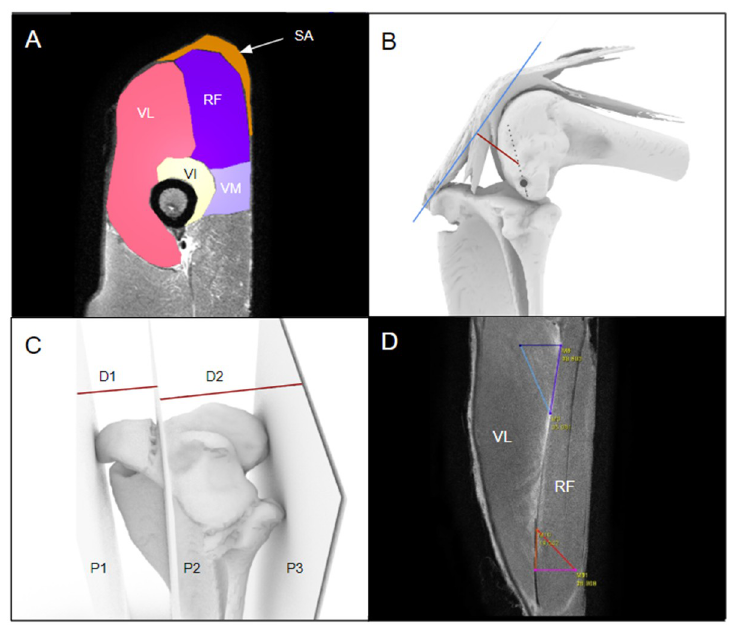
Figure 3. Static characteristics of the kangaroo stifle were derived from the 3D models by measuring: ( A ) The muscle cross-sectional areas, with the VL, VI, VM, RF and SA labelled; ( B ) the moment arm, shown in red. The grey dot marks the sulcus where the lateral collateral ligament attached, and the grey dotted line represents the axis of rotation of the femoral condyles. The plane representing the line of action of the extensor mechanism is shown in blue; ( C ) the TP:TT ratio and the TT projection index, and ( D ) the muscle pennation angles of the VL and RF.